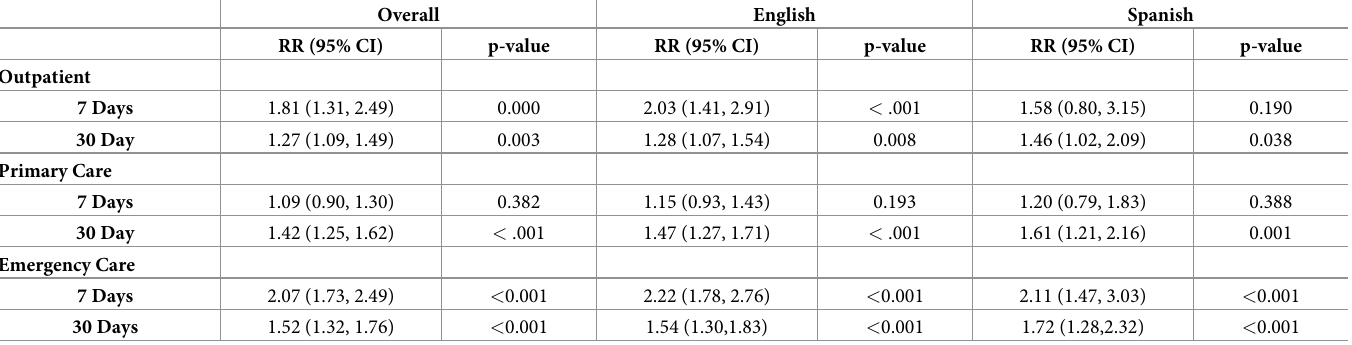
Table 4. Care utilization after the initial COVID-19 encounter in COVID-19 positive home monitoring participants versus propensity-weighted COVID-19 posi- tive controls.